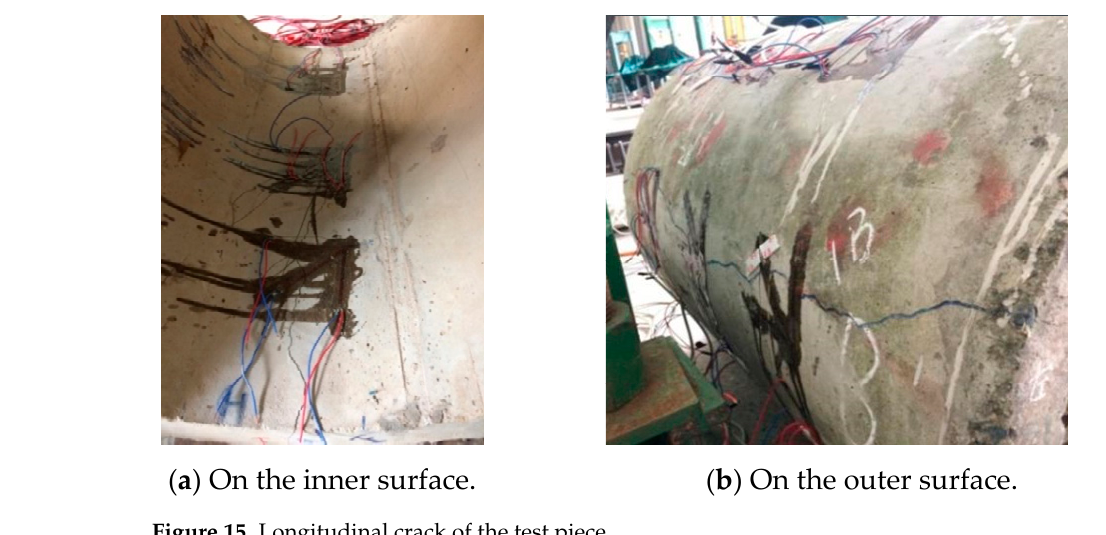
Figure 15. Longitudinal crack of the test piece.